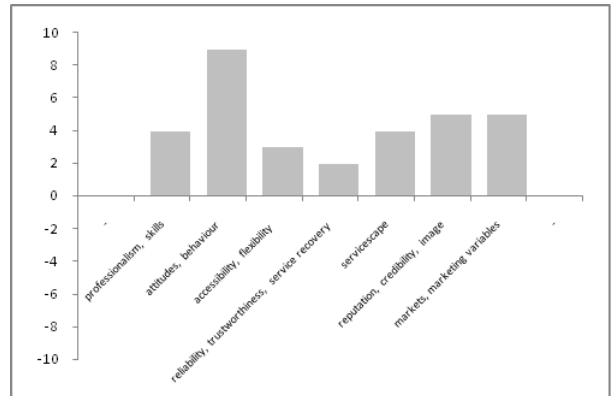
Figure 4: The underlying drivers of consumption in Factor 1